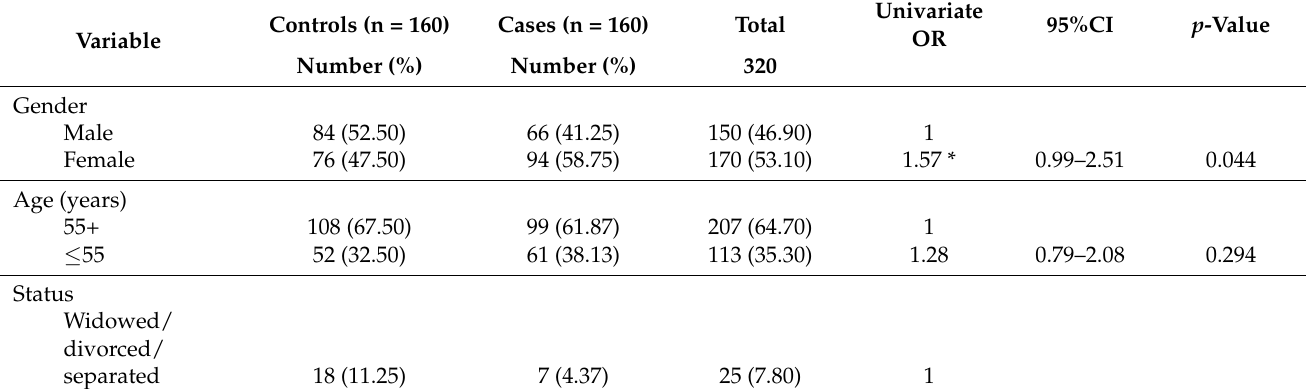
Table 1. Baseline characteristics of 320